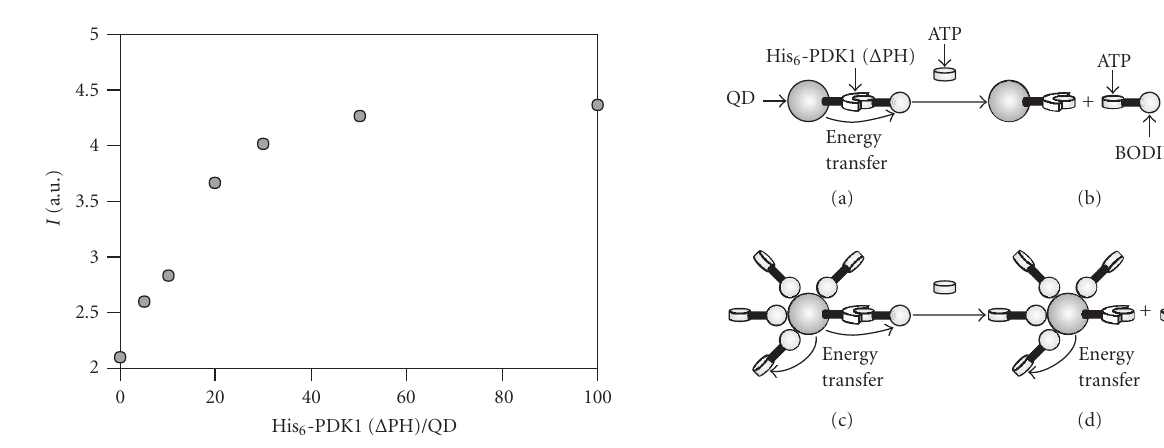
Figure 2: Emission intensity at 600nm of CdSe-ZnS core-shell QDs (0.1 μ M in borate bu ff er, pH = 7.4, T = 20 ◦ C, λ EX = 442nm) coated with DHLA against the ratio between the concentration of His 6 - PDK1( Δ PH) and that of the QDs.